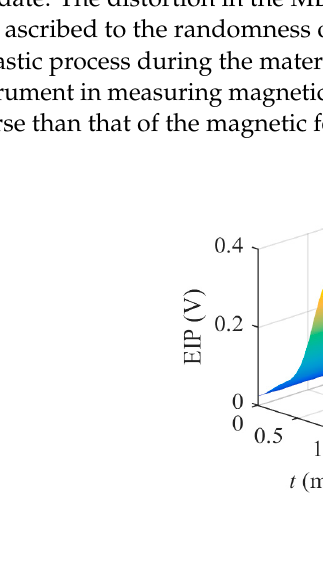
Figure 4. The 3D images of ( a ) MBN and ( b ) EIP envelop recorded in repeatability tests.